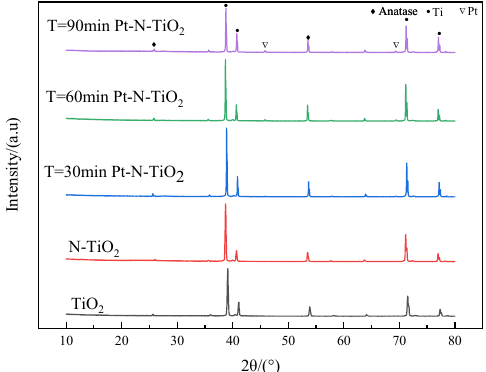
Figure 3. XRD pattern of each nanotube.